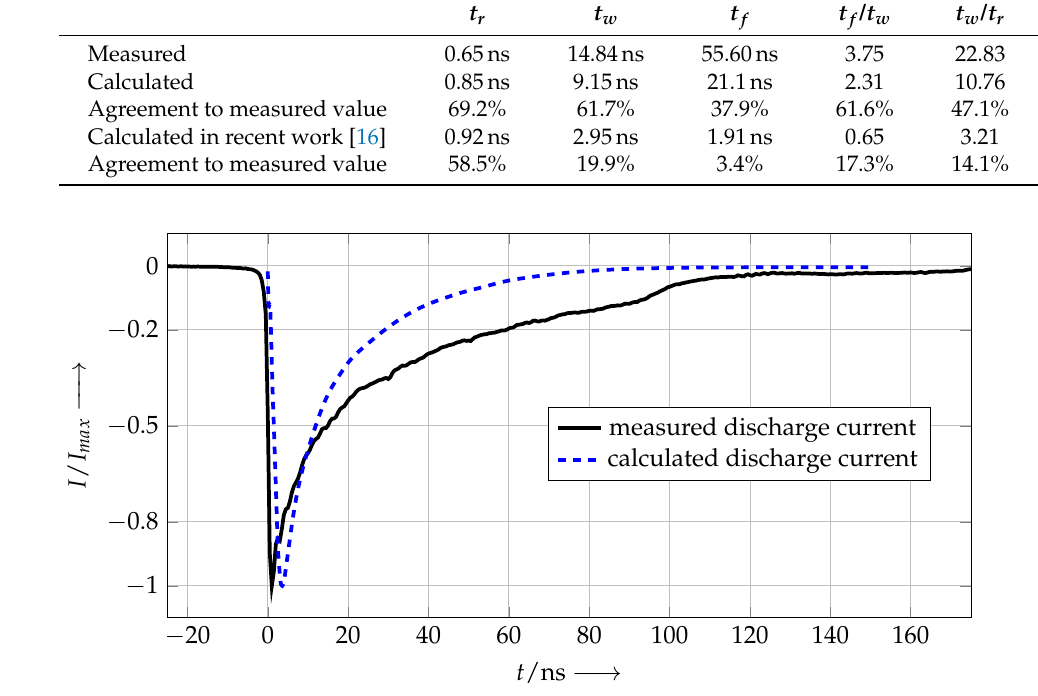
Figure 11. Measured and calculated discharge